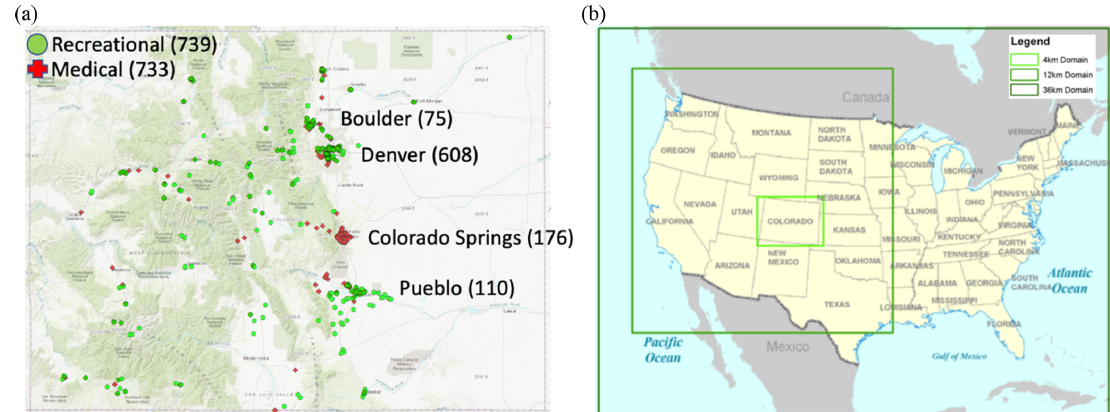
Figure 1. (a) The locations of medical (red) and retail (green) Cannabis cultivation facilities (CCFs) in Colorado as of 1 March 2018. The corresponding values are the number of CCFs found within each city. The base map layer of this figure was made by Esri (Esri et al., 2013). (b) The 36km × 36km resolution of Western Air Quality Study (WAQS) and nested inner 12km × 12km resolution domains and 4km × 4km resolution domain used by the Comprehensive Air Quality Model with extensions (CAMx). This map was made by ENVIRON and Alpine Geophysics (ENVIRON and Alpine Geophysics, LLC,